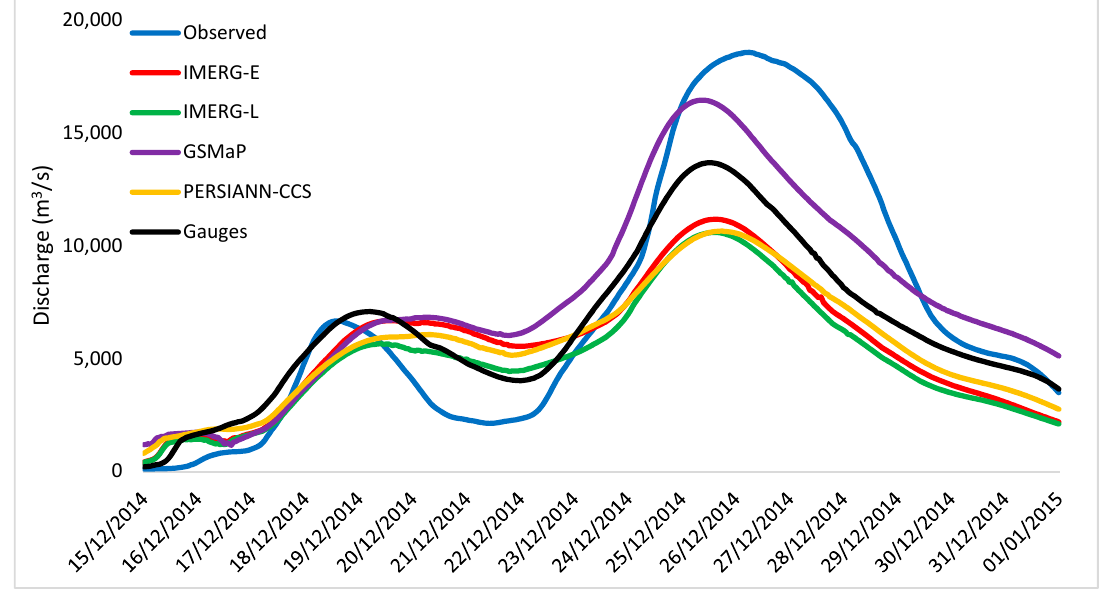
Figure 5. Comparison of hydrograph of observed discharge and simulated discharges.